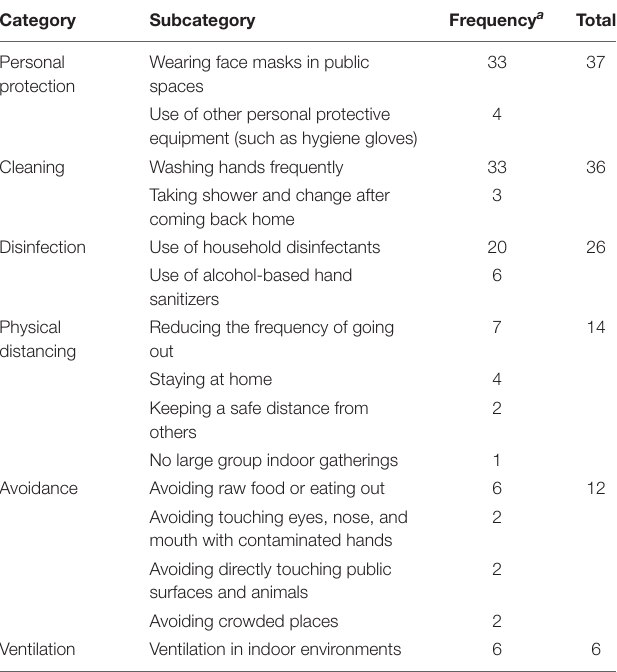
TABLE 4 | Categorization of pre-service teachers’ current personal hygiene